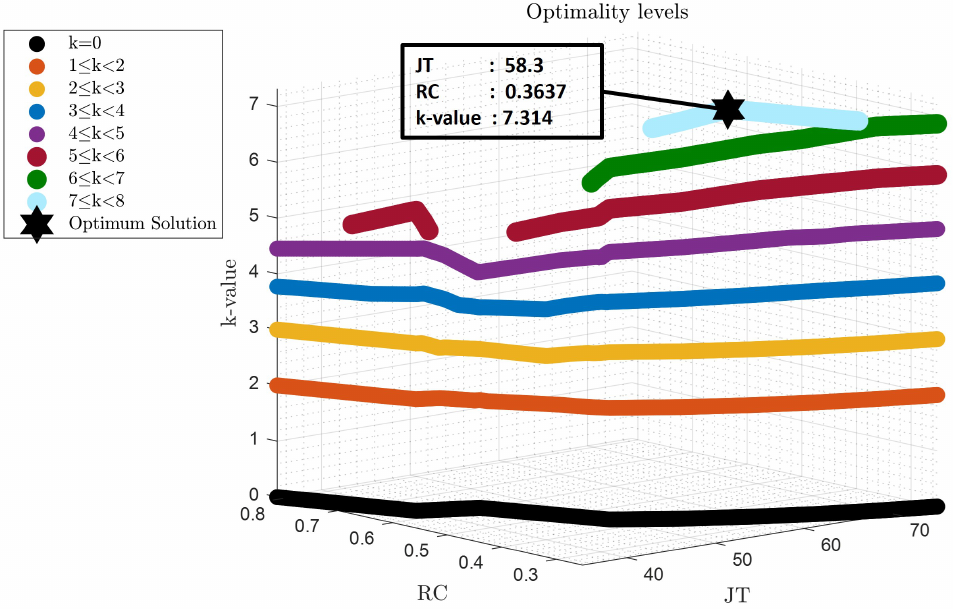
Figure 7. Optimum solution obtained by the sorting algorithm considering multiple design criteria ( RC , AD , EE , STF , STR , LTF , LTR , SF D and SF P